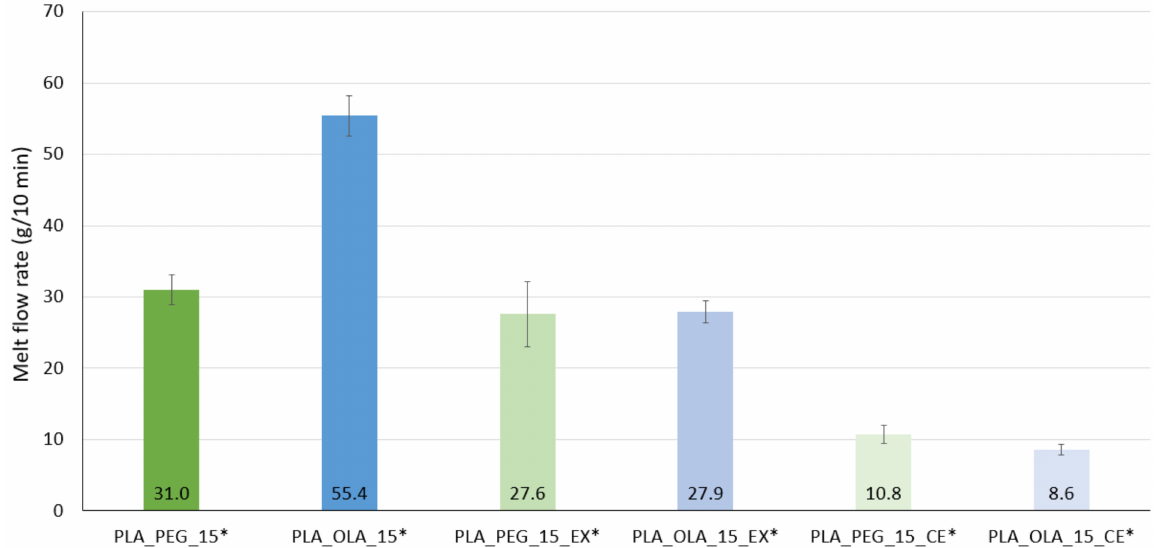
Figure 13. Mass flow rates (in g/10 min) of the up-scaled formulations achieved at 190 ◦ C and with a weight of 2.16